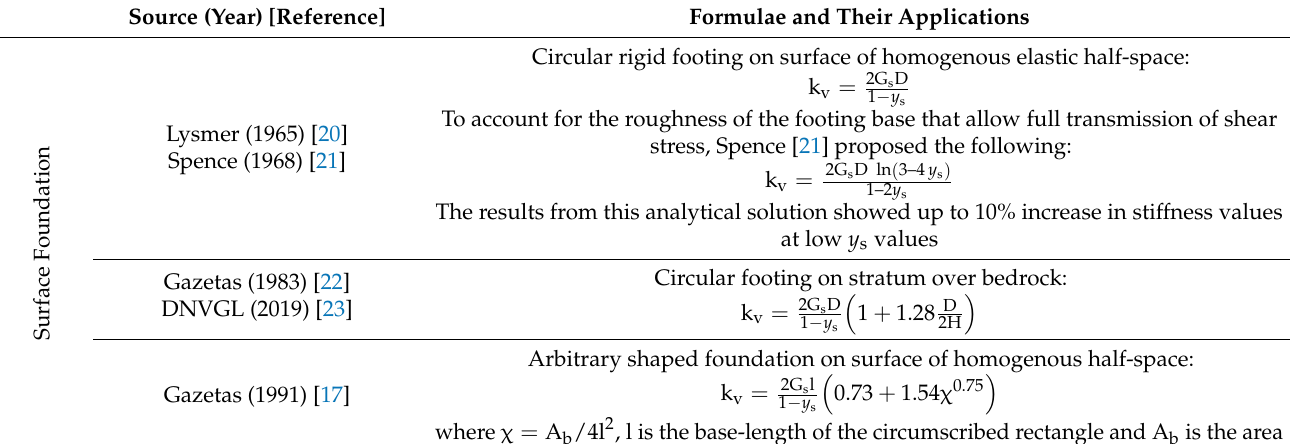
Table 1. Methods to estimate the vertical stiffness of the foundation in